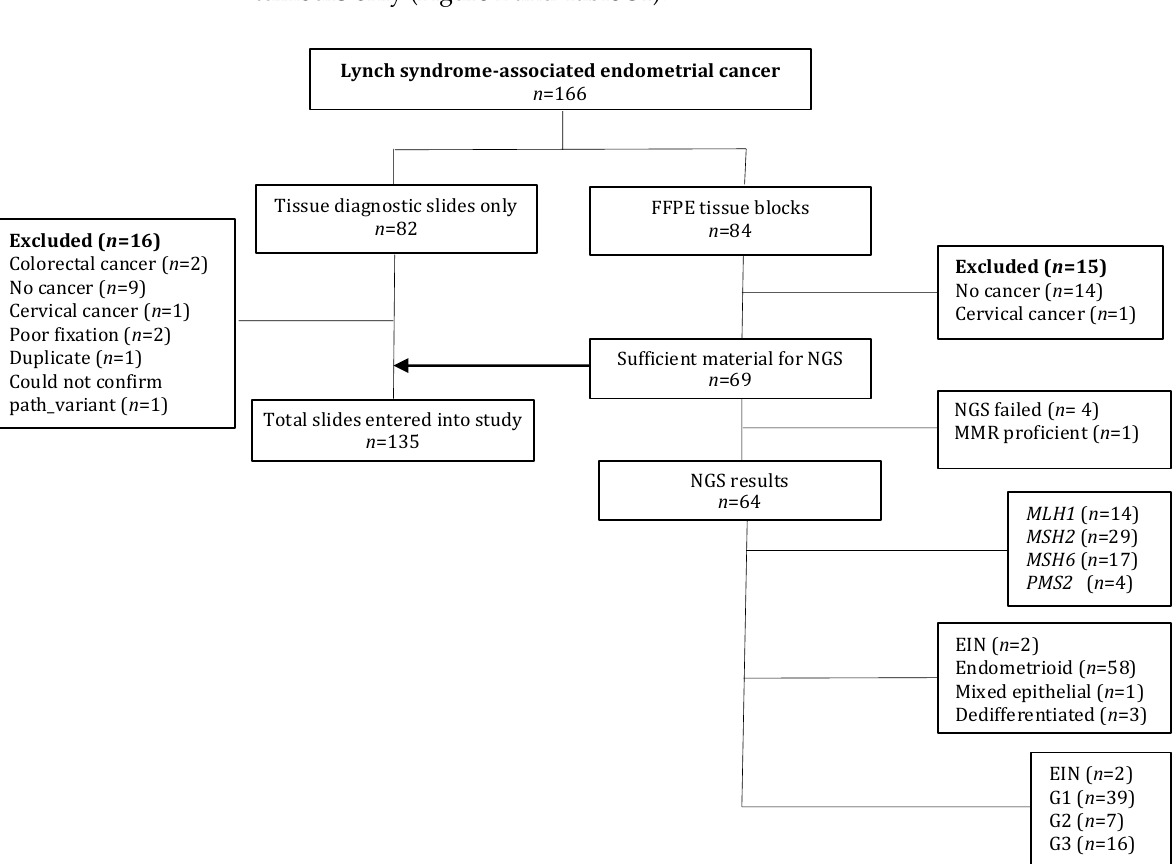
Figure 1. Study flow diagram Abbreviations: EIN: endometrial intraepithelial neoplasia; FFPE: formalin-fixed, paraffin- embedded; G: grade; NGS: next-generation sequencing; NK: not